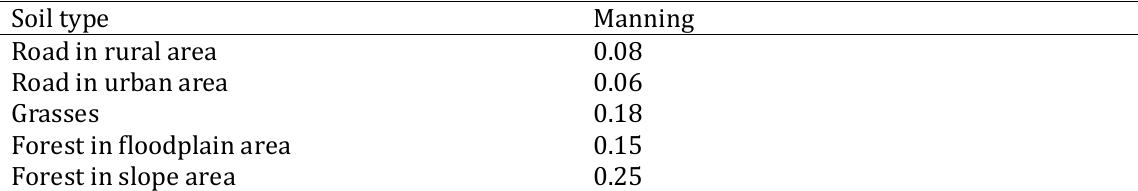
Table A1.2. Manning values used for the study